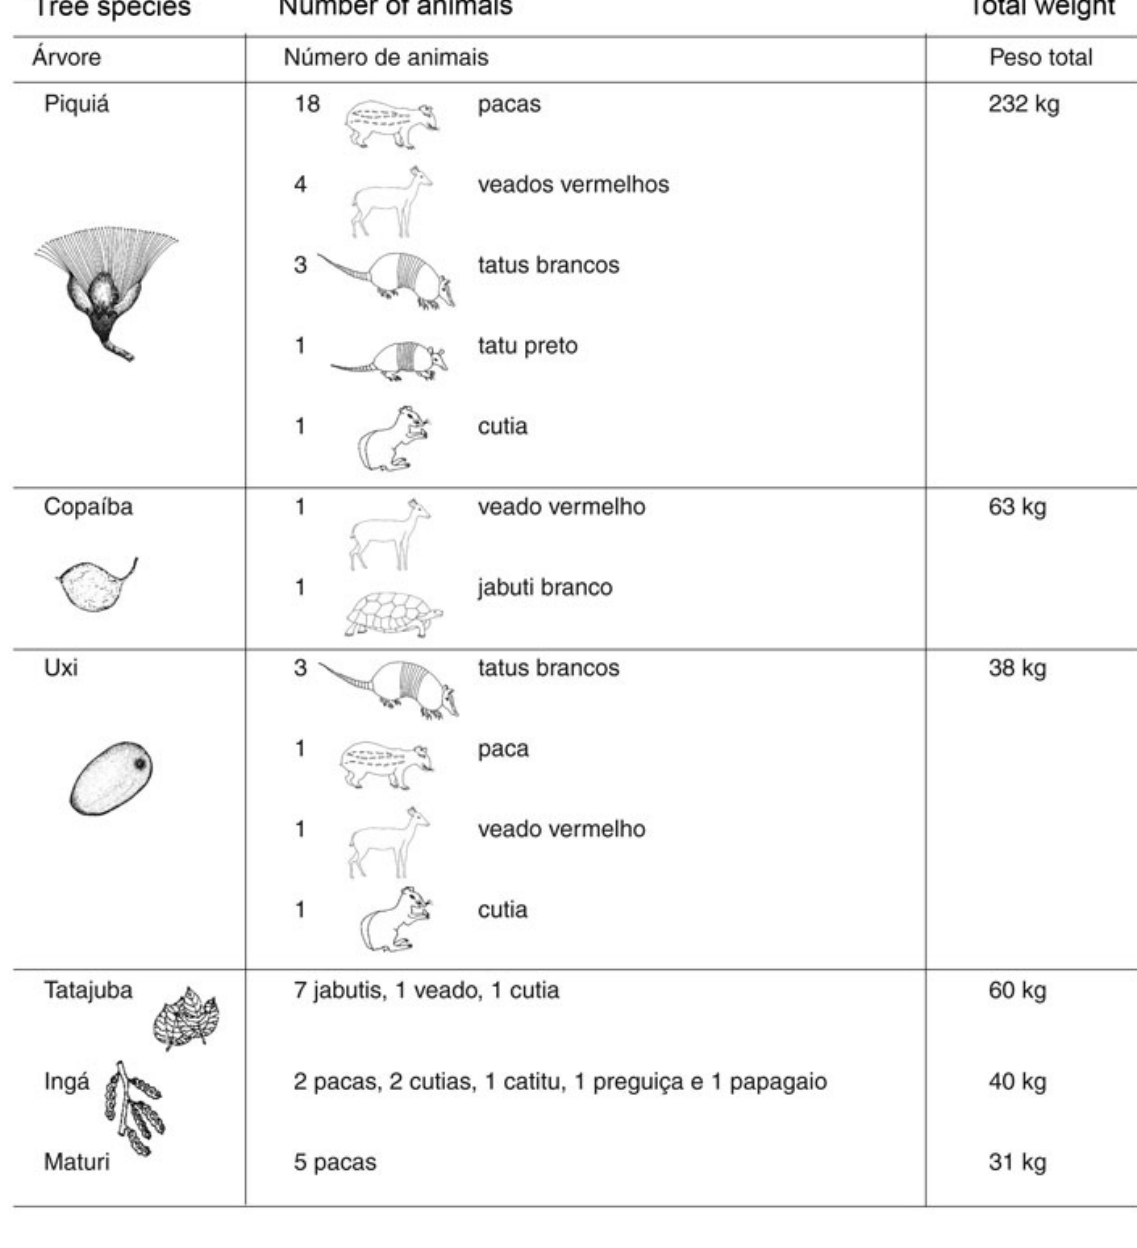
Fig. 2. Quantities of game animals captured beneath different tree species during 1 yr in one Capim River community. Source: Cymerys in Shanley and Medina